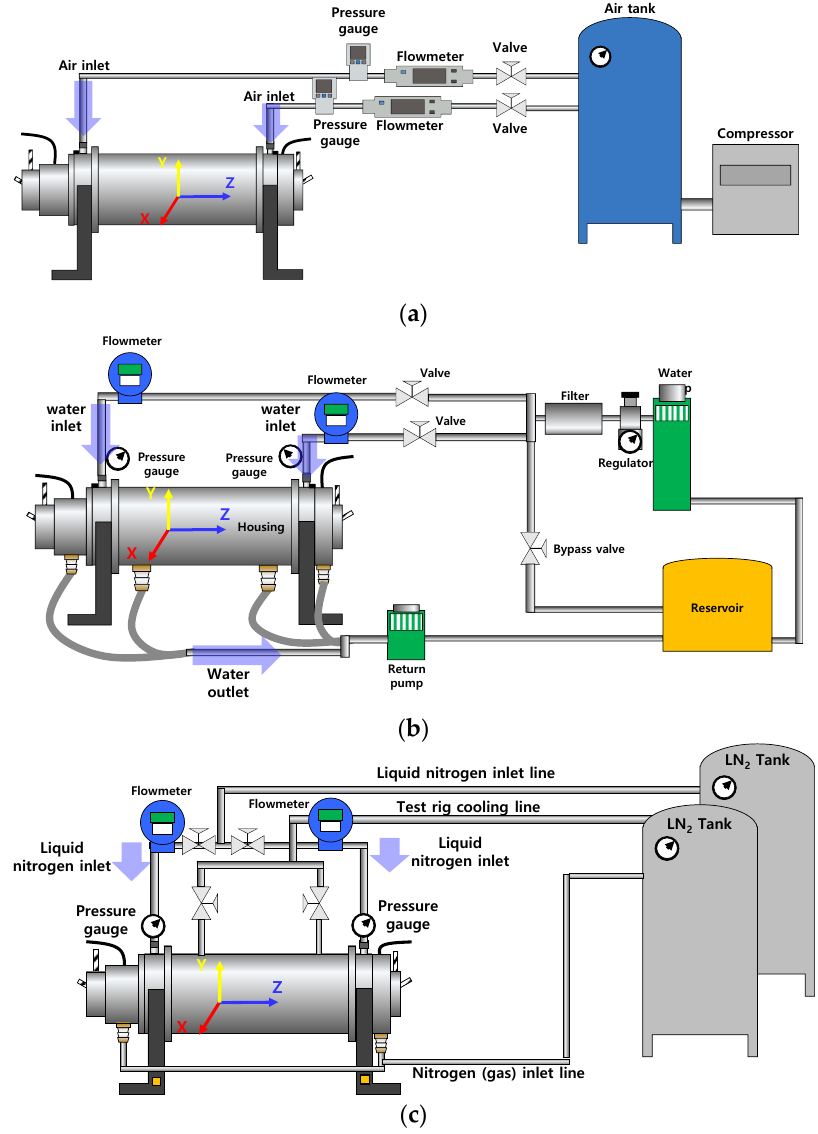
Figure 3. Schematic view (not to scale) of test fluid supply systems. ( a ) System configuration for air-lubricated bearing tests. ( b ) System configuration for water-lubricated bearing tests. ( c ) System configuration for liquid-nitrogen-lubricated bearing tests.